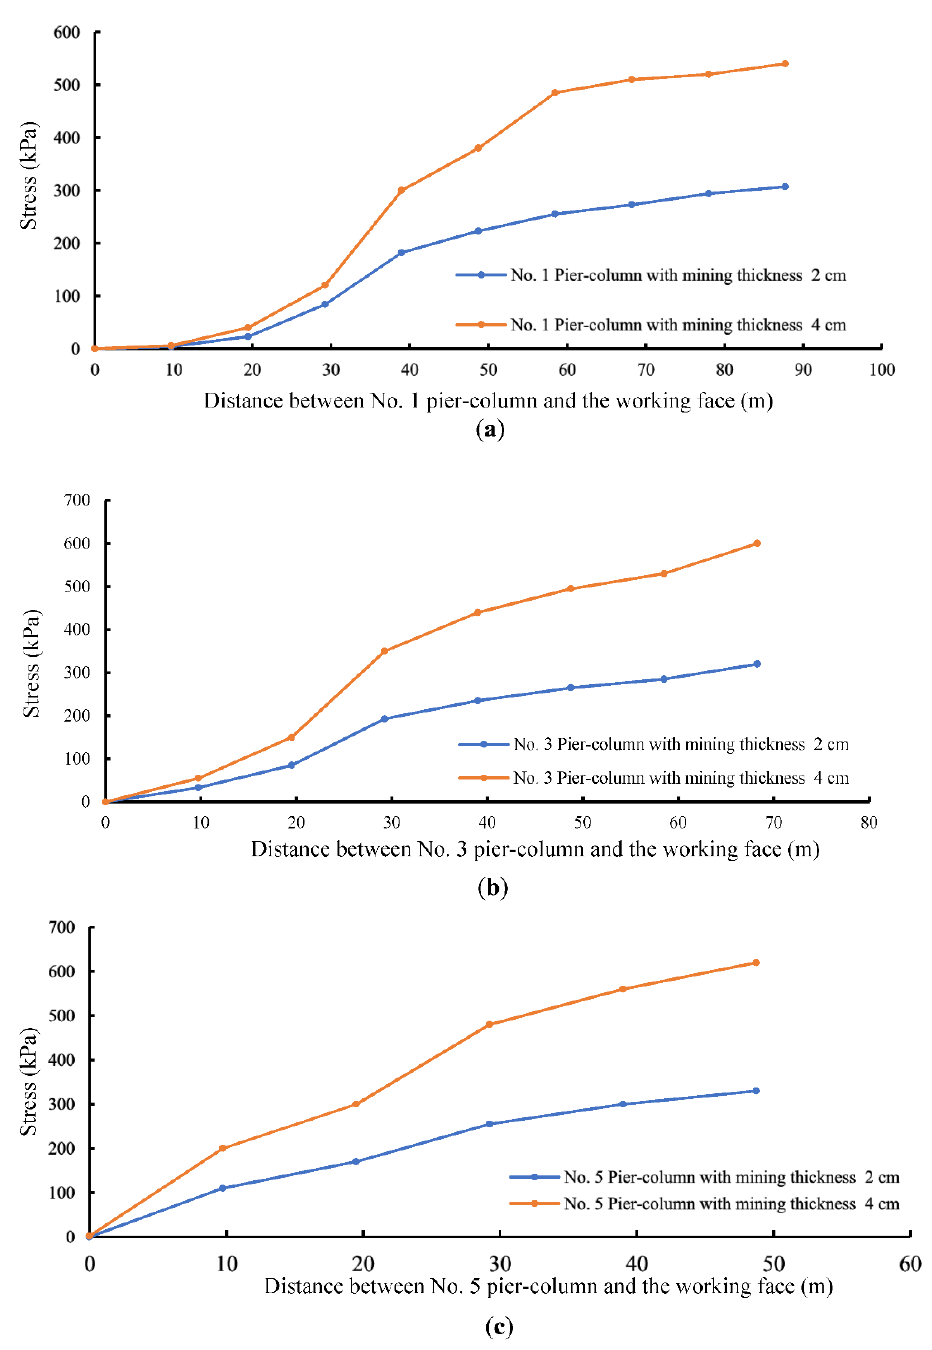
Figure 10. Curve of the stress of different pier-columns: ( a ) No. 1; ( b ) No. 3; ( c ) No. 5.